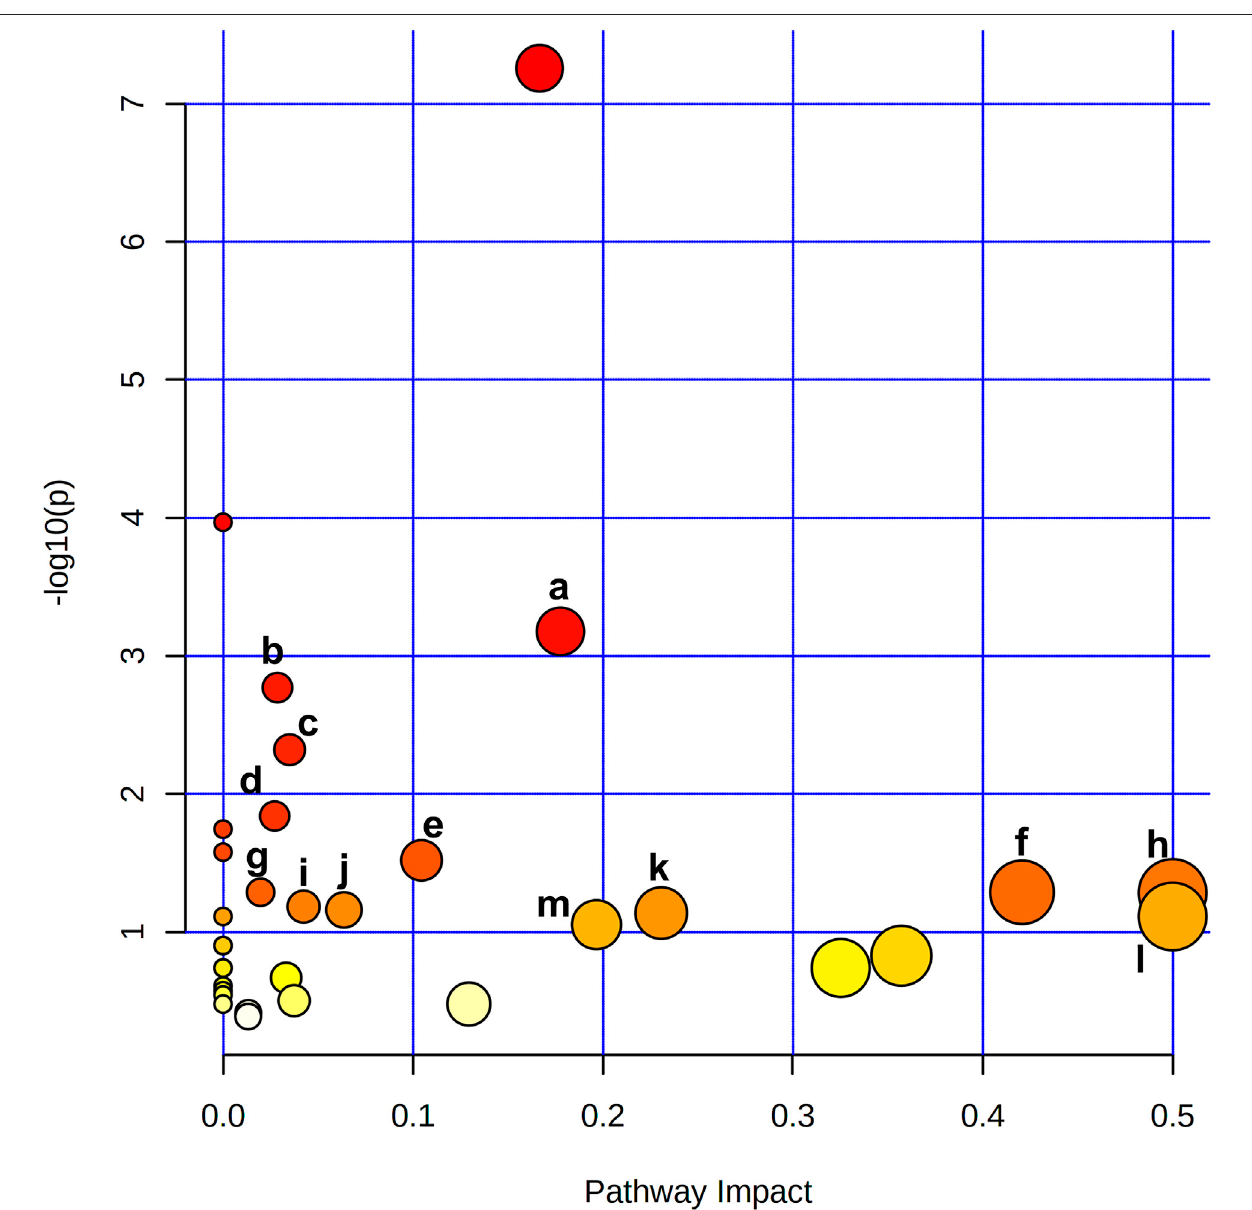
FIGURE 5 | Metabolite pathway analysis based on metabolites displayed signi fi cant variation in the serum revealed that a. Arginine biosynthesis, b. Pantothenate and CoA biosynthesis, c. Galactose metabolism, d. Valine, leucine and isoleucine degradation, e. beta-Alanine metabolism, f. Alanine, aspartate and glutamate metabolism, g. Glutathione metabolism, h. Phenylalanine, tyrosine and tryptophan biosynthesis, i. Glyoxylate and dicarboxylate metabolism, j. Cysteine and methionine metabolism,k.Glycine,serineandthreonine metabolism,l.D-Glutamineand D-glutamatemetabolism,m. Arginineandproline metabolism werethemostaffected pathways after 2/3